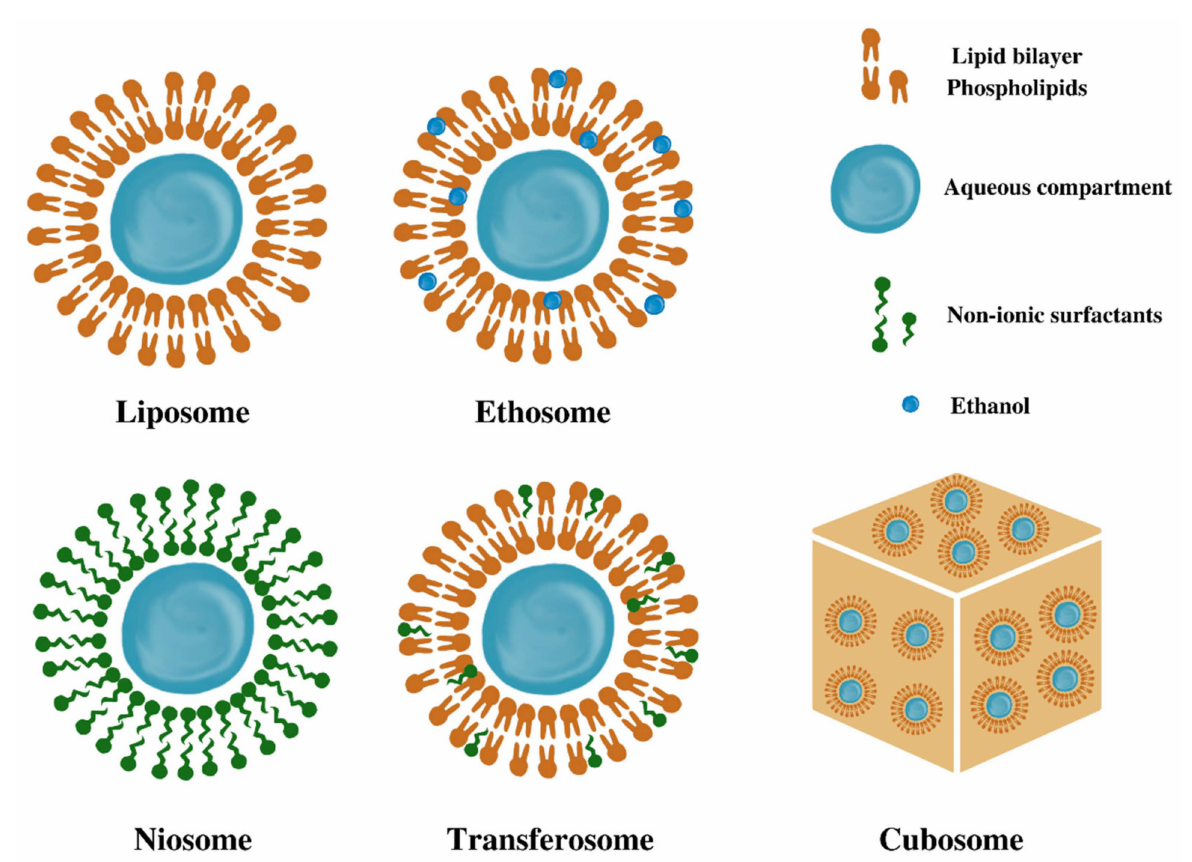
Figure 5. The main types of vesicular nanosystems with potential applications in wound